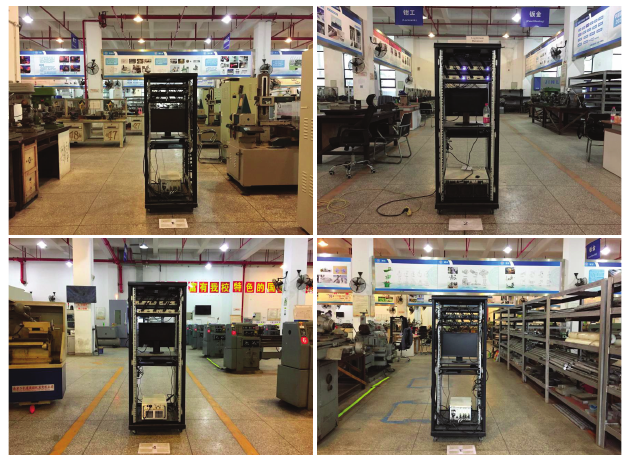
Figure 9. The location of the wireless sensor nodes in the practical industrial scenario.